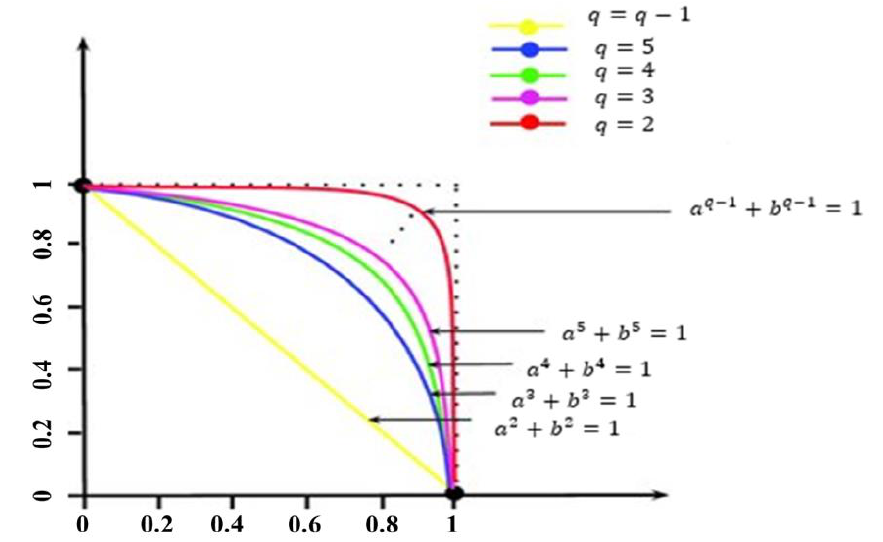
Figure 1. Geometrical interpretation of q-rung orthopair fuzzy sets. Here 𝑎 = 𝝁,𝑏 = 𝜼 .